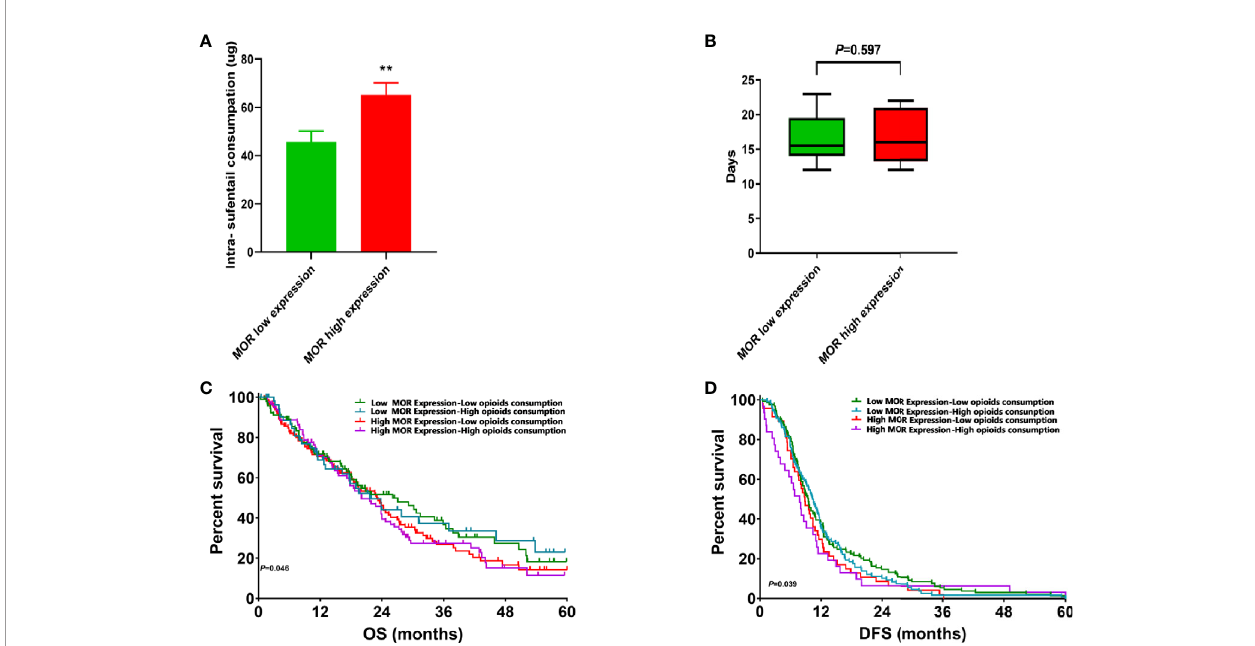
FIGURE 1 | (A) Intraoperative sufentanil consumption according to MOR expression; (B) Length of stay according to MOR expression; (C) Subgroup analysis of OS curves according to MOR expression and opioids consumption. (D) Subgroup analysis of DFS curves according to MOR expression and opioids consumption. **P <